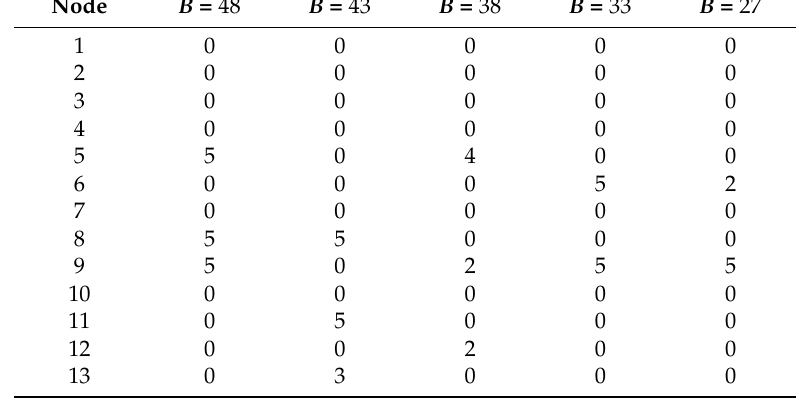
Figure 10. Comparison of the energy recharged for various total cost budgets.